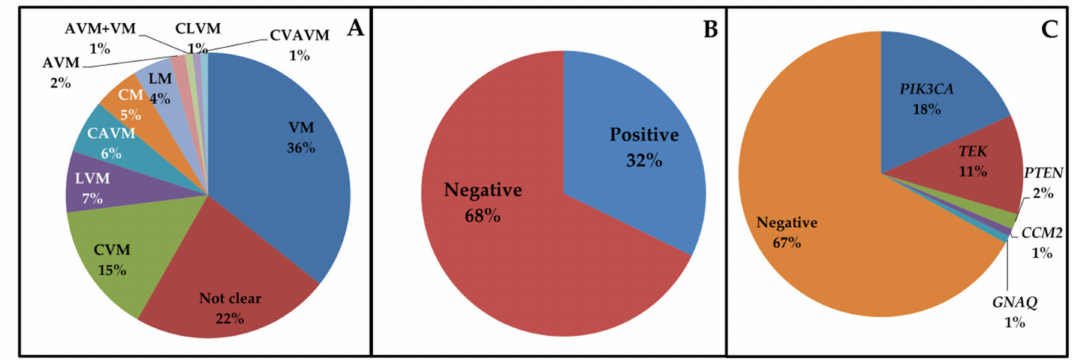
Figure 1. ( A ) Relative percentage of vascular malformations a ff ecting patients. AVM = Arteriovenous malformation; CAVM = Capillary–Arteriovenous malformation; CLVM = Capillary–Lymphatic–Venous malformation; CM = Capillary malformation; CVAVM = Capillary–Venous–Arteriovenous malformation; CVM = Capillary–Venous malformation; LM = Lymphatic malformation; LVM = Lymphatic–Venous malformation; VM = Venous malformation. ( B ) Relative percentage of negative and positive cases after genetic testing. ( C ) Relative percentage of the mutated